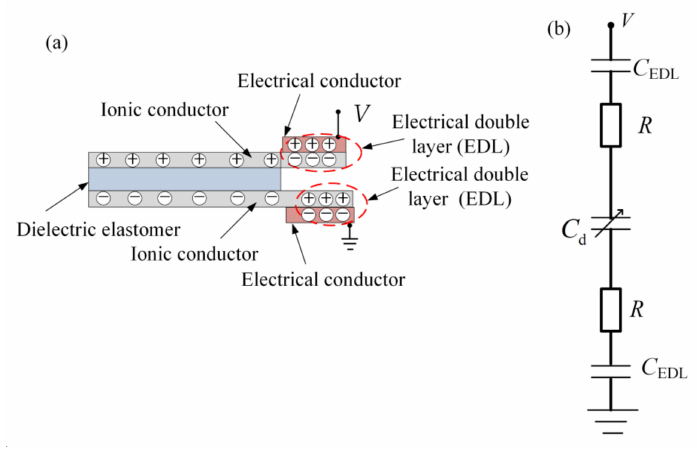
Figure 2. ( a ) Charge distribution and ( b ) equivalent circuit of ionic skin [17].